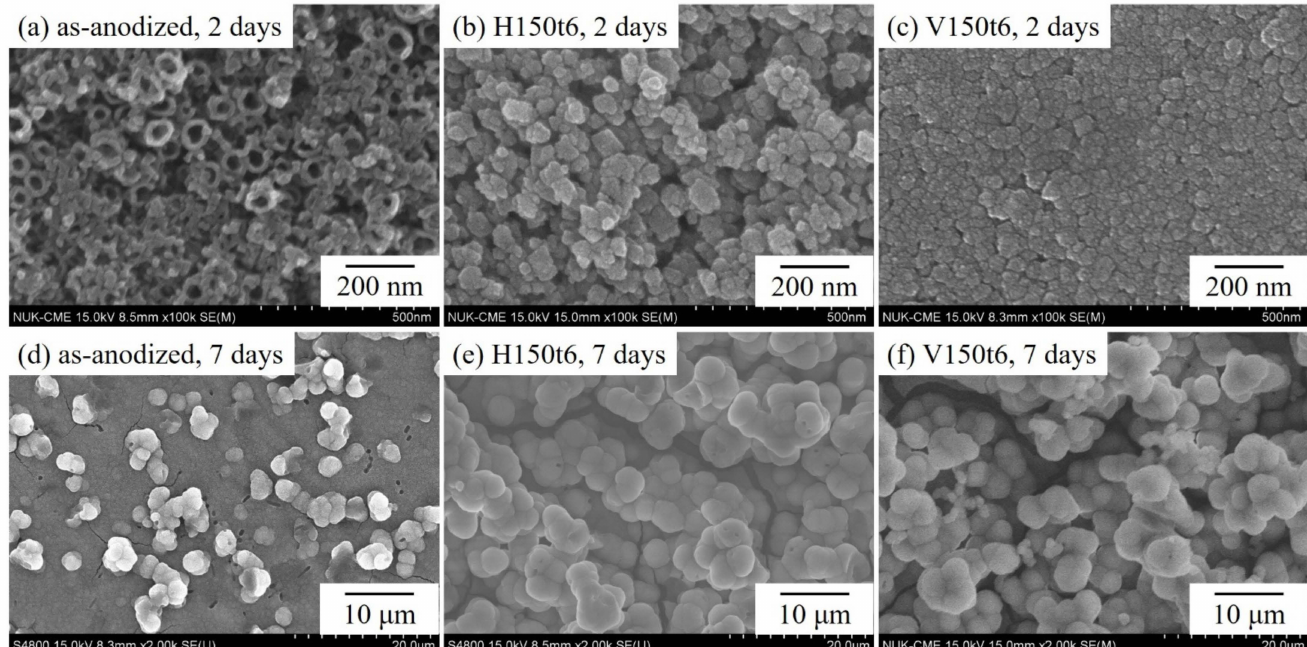
Figure 5. SEM images of anodized Ti–5Nb–5Mo under hydrothermal or vapor thermal treatments at 150 ◦ C for 6 h after soaking in SBF for 2 or 7 days: ( a ) as-anodized, 2 days, ( b ) H150t6, 2 days, ( c ) V150t6, 2 days, ( d ) as-anodized, 7 days, ( e ) H150t6, 7 days, and ( f ) V150t6, 7